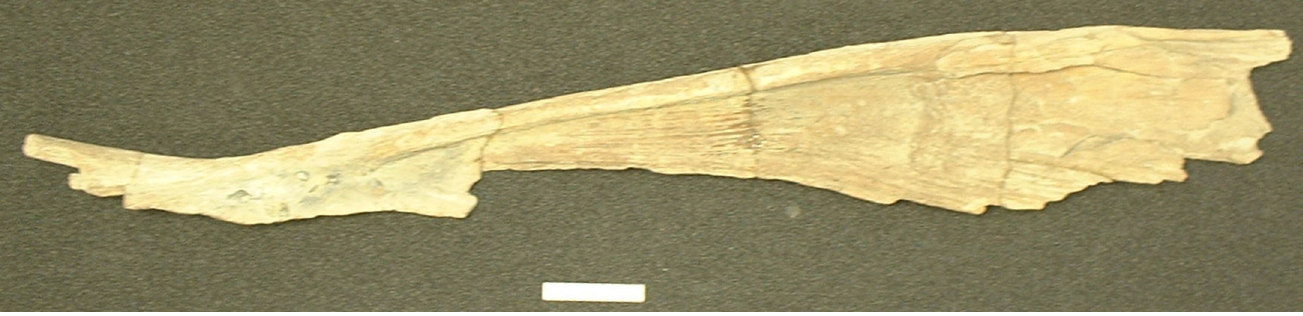
Figure 4. Left maxilla of Leedsichthys (GLAHM V3363, 695 mm long) with a perfectly smooth and intact ventral surface. Scalebar = 50